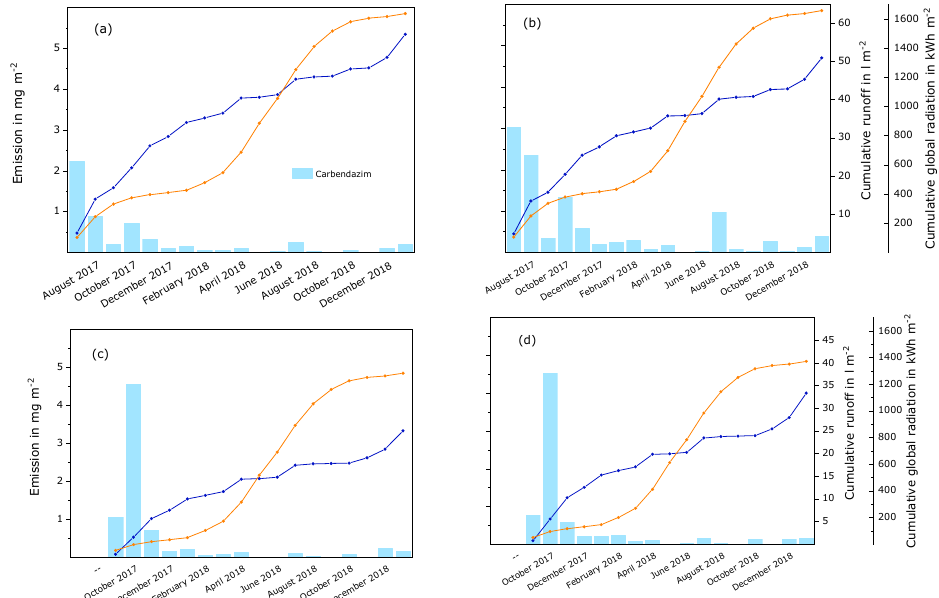
Figure 5. Monthly emissions of carbendazim from a white and a red paint film during semi-field experiments that were started in July 2017 (experiment A) and September 2017 (experiment B). The columns represent carbendazim that was detected in runoff samples per month. The blue curves show the cumulated volume of runoff samples per surface area for each experiment. The orange curves show the cumulative global radiation during the experiment. ( a ) Experiment A, white paint; ( b ) experiment A, red paint; ( c ) experiment B, white paint; ( d ) experiment B, red paint.